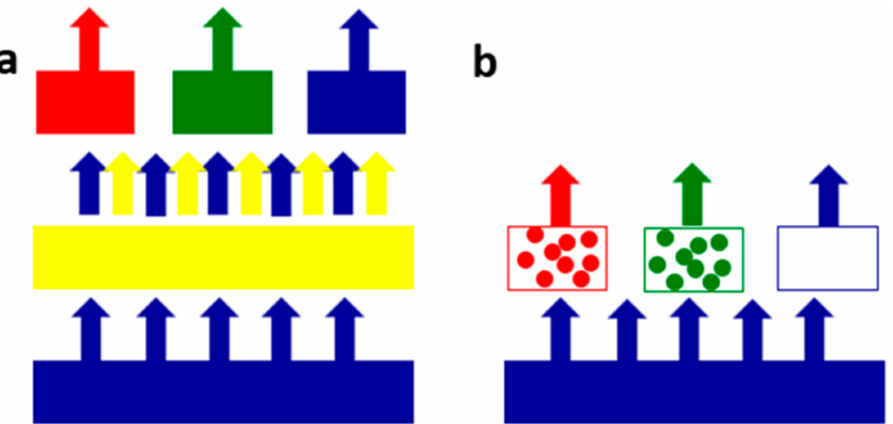
Figure 1. The structure of ( a ) traditional LCD backlight ( b ) QDCF excited by a blue backlight (Ex ≈ 450